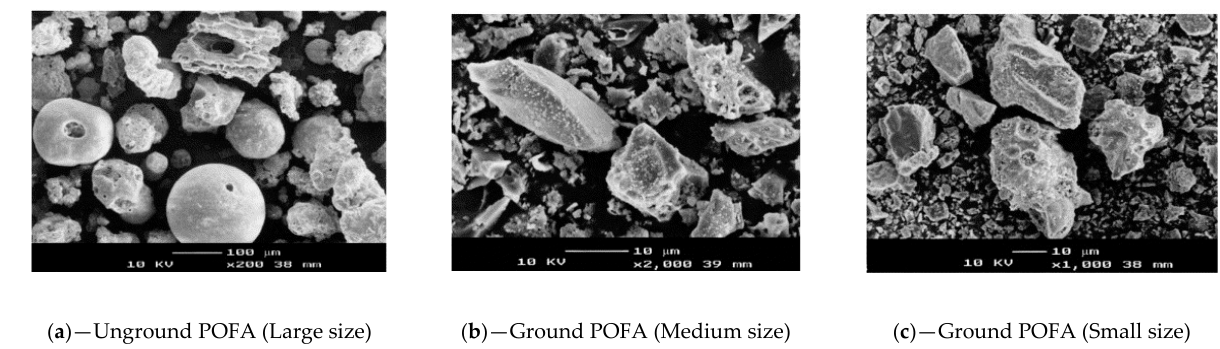
Figure 7. Scanning electron micrographs (SEMs) of OPC and POFA [22]. Reprinted with permission from Elsevier [22].